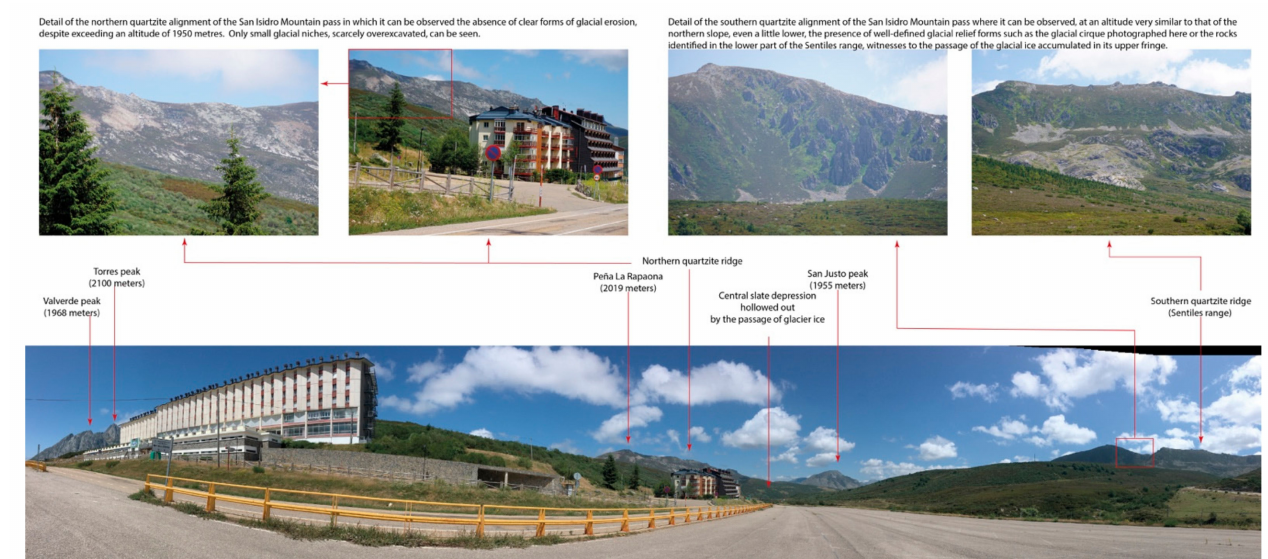
Figure 13. 360 ◦ photograph from the fourth POI. Photograph by the authors. Photograph by the authors. Focus with camera on Figure through Onirix site or use the link